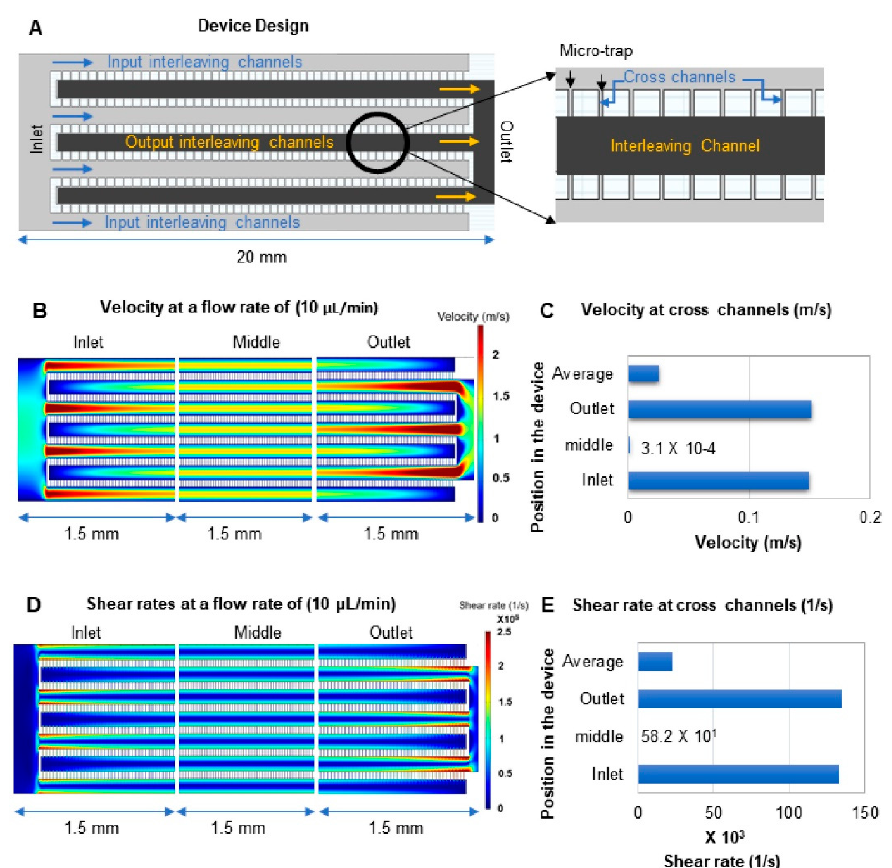
Figure 2. Simulations of the microtrap device. ( A ) 2-D CAD design of the microtrap device used for COMSOLsimulations showing theinterleavingnetwork fortheflow offluid, andthecross-channels, which produce the microtraps when a cover plate is sealed to the device. The magnified image of the microtrap area is shown on the right with a single interleaving output channel (red) and two interleaving input channels (gray). ( B ) The simulated linear fluid velocity throughout the microtrap chip. The simulation shows three sections of the device: (i) input section; (ii) middle section; and (iii) outlet section. Flow was simulated across the interleaving input / output channels and the cross-channels. The dashed box shown here is the region of the device that was simulated in Figure S3 (see Supplementary Materials). ( C ) Bar graph representing the mean velocities expressed in m / s observed for the cross-channels at di ff erent sections of the device and at a 10 µ L / min volume flow rate. The sections labeled here correspond to the sections of the device simulated in ( B ). ( D ) Simulated shear rate at three di ff erent sections of the device, inlet, middle, and outlet sections. ( E ) Bar graphs representing the mean shear rates across the cross-channels at di ff erent sections of the device at a volume flow rate of 10 µ L / min. The sections of the device listed here correspond to those sections shown in ( D